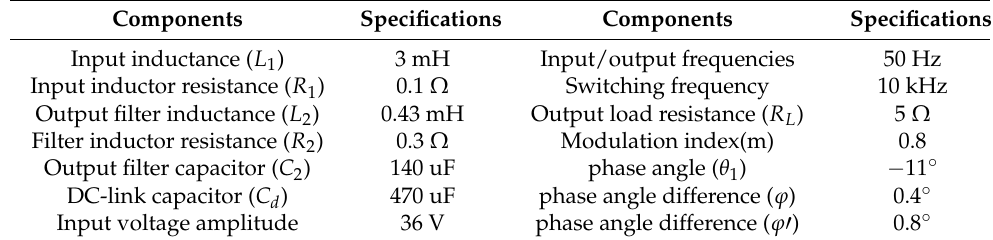
Table 2. Simulation parameters.